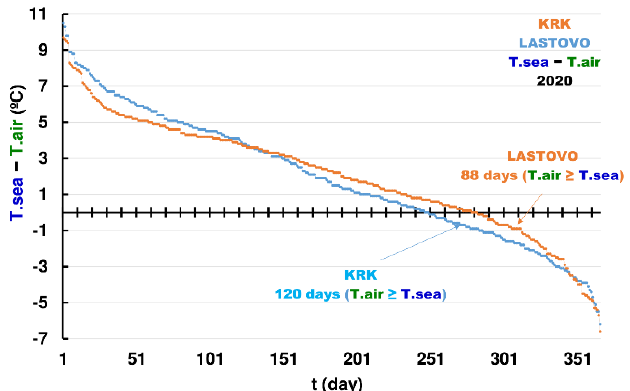
Figure 16. Duration curves of the differences between the mean daily sea surface temperatures at Lastovo (brown) and Krk (blue) calculated for 2020.